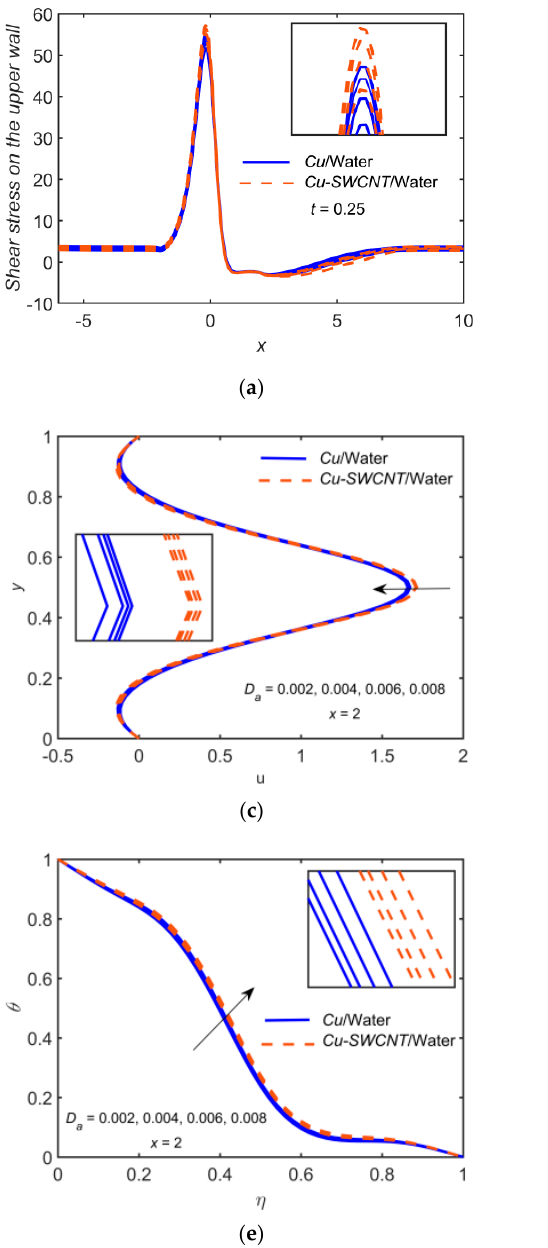
Figure 6. ( a ) The WSS distribution, ( b ) u profile at x = 0, ( c ) u profile at x = 2, ( d ) θ profile at x = 0, ( e ) θ profile at x = 2, and ( f ) ϕ profile at x = 0 for distinct values of D a